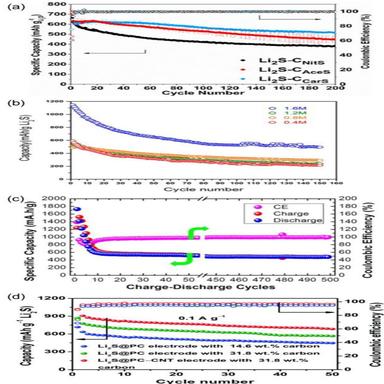
(a) Cycle stability of these composites (Li2S-CNitS, Li2S-CAceS, Li2S-CCarS) at 117 mA=g Li2 S . (b) Cyclability (based on discharge capacity) of cathodes fabricated with Li2S NCs as a function of solution concentration via the reaction between EtOLi and H2S. (c) Cyclability and Coulombic efficiency of Li2S films deposited onto 2D planar Cu foils via ALD method. (d) Cyclic performance comparison of Li2S@PC-CNT and Li2S@PC electrodes at a current density of 0.1 A=g L